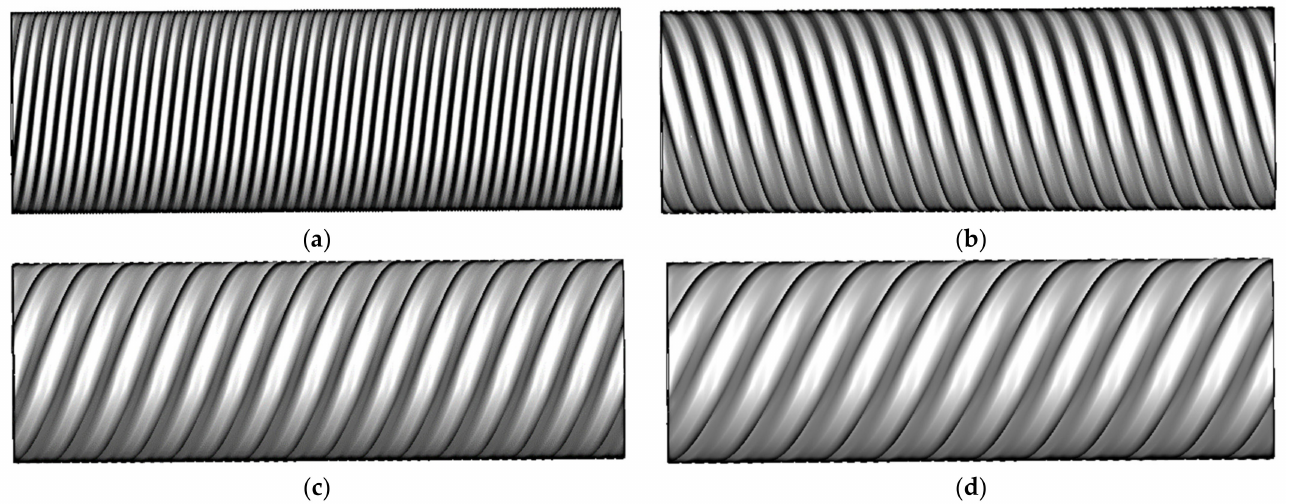
Figure 3. The schematics of the evaluated geometries in the second section of present work. ( a ) P = 250 mm, ( b ) P = 500 mm, ( c ) P = 750 mm and ( d ) P = 1000